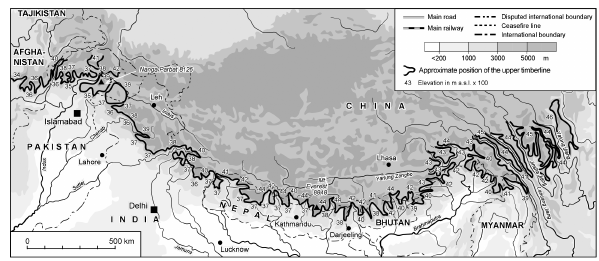
Figure 1. Altitudinal position of alpine treeline in the Himalayan mountain system (north-facing slopes) (modified after Schickhoff,